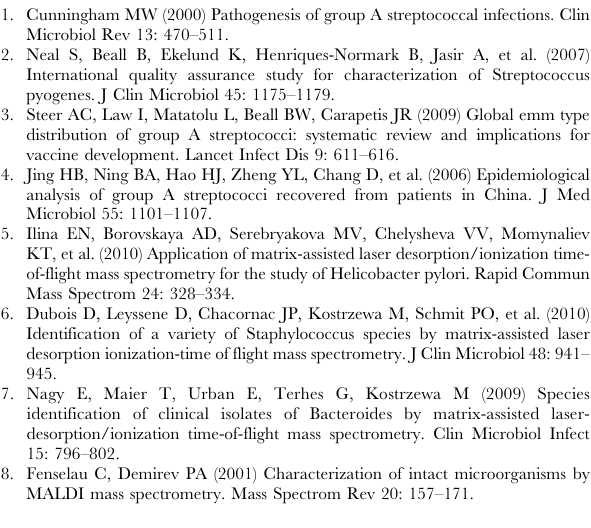
Table S11 Peaklist for M63, M64, M75, M86 and M95 type isolates. m/z – intensity values of top 50 major peaks were listed. It includes one M63 type isolates (G302), one M64 type isolates (8626), one M75 type isolates (8627), one M86 type isolates (8642), one M95 type isolates